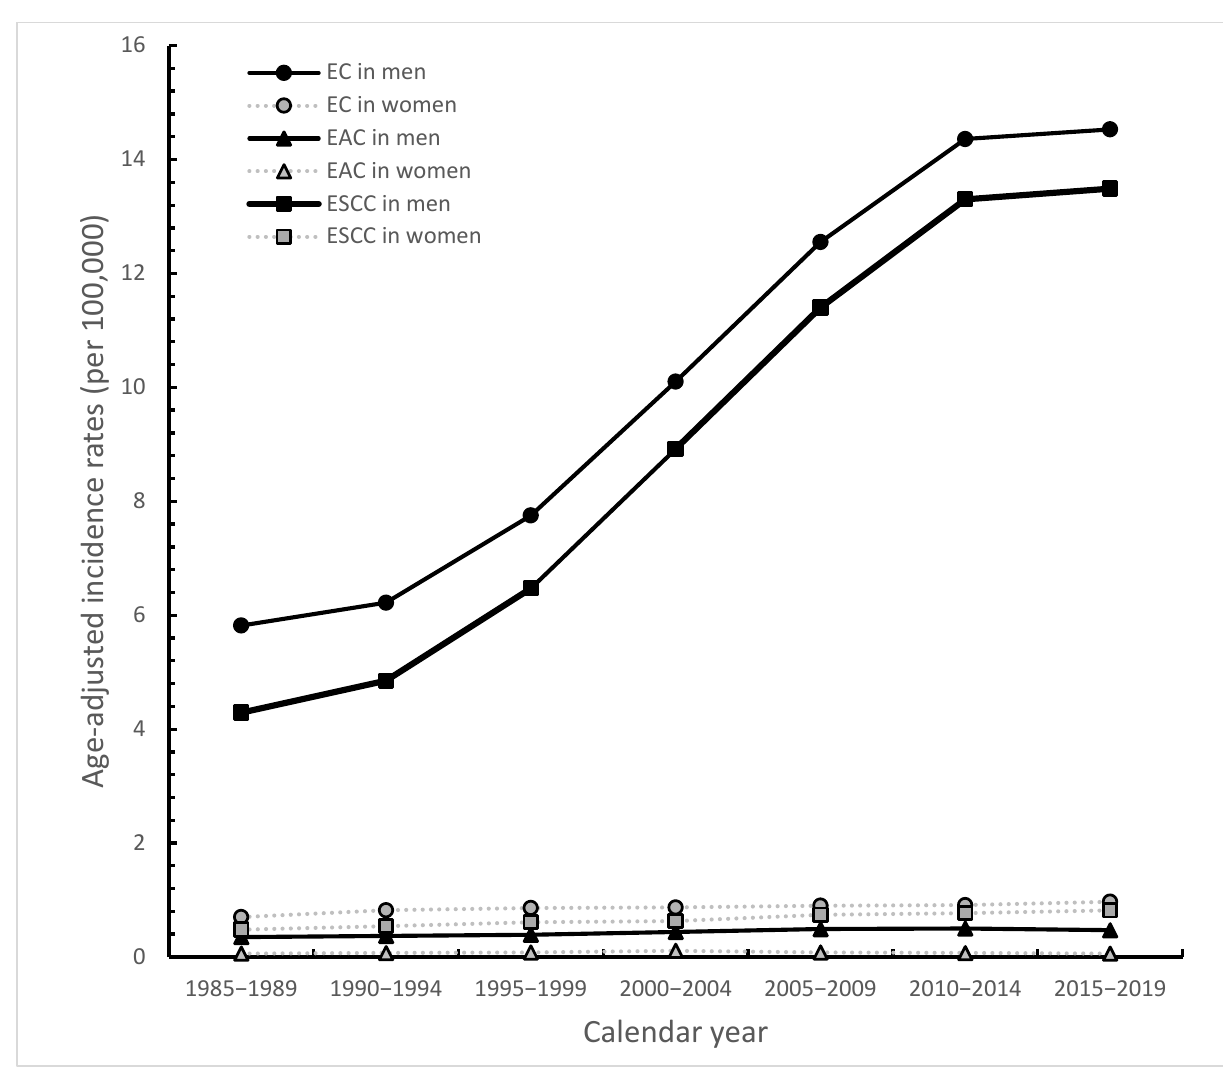
Figure 1. Secular trends of age-adjusted incidence rates of esophageal cancer (EC), esophageal squamous cell carcinoma (ESCC), and esophageal adenocarcinoma (EAC) by sex in Taiwan for the period 1985–2019. Table 1. Annual percent change (APC) and average annual percent change (AAPC) in EC, ESCC and EAC rates for the period 1985–2019, by sex.